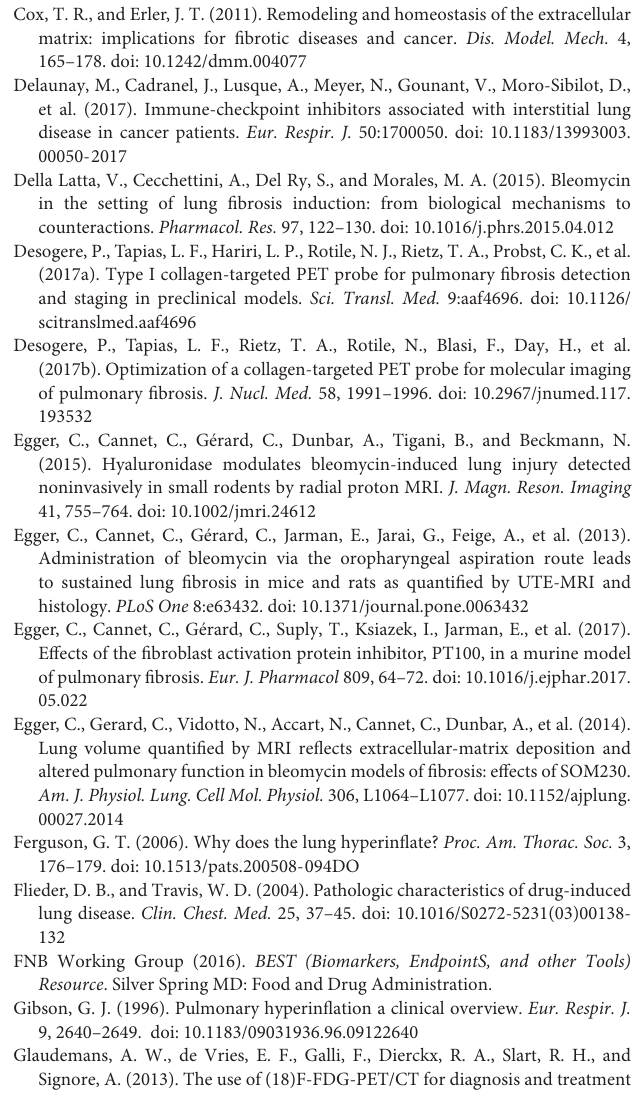
FIGURE S3 | Histogram analysis within the region of interest (ROI). (A) Schematic image explaining how the histogram analysis method was done. Intersection of the slope at the x-axis is where the boarder is set, serving as the threshold value between the normal signal vs. high-signal within the lung. Controls (Saline) and bleomycin challenged lungs exert somewhat different shape of the histograms generated from the lung ROI. (B) Images of representative MR-scans from two rats, one from each group of saline (I) and bleomycin (II). After drawn ROI of the lungs (red area) in the same rat from saline (III) and bleomycin (IV) with cyan colored areas indicating “high MR-signal”, segmented by using the histogram thresholding analysis. High-signal signified lesions and vessels within the lungs (or only vessels in control animals). FIGURE S4 | Glucose levels monitored before each imaging scan. Blood glucose measurements before each scan session from day 3 (A) , 7 (B) , 14 (C) , 21 (D) and 28 (E) . FIGURE S5 | Body weight and disproportional lung volume increase in bleomycin-challenged rats. Body weight (A) and lung-ratio presented (B) according to the split bleomycin-challenged group into low- vs. high-responders to bleomycin-induced lung injury. Lung ratio was generated by calculating lung volume per body weight at that particular scan session, and presented as mean